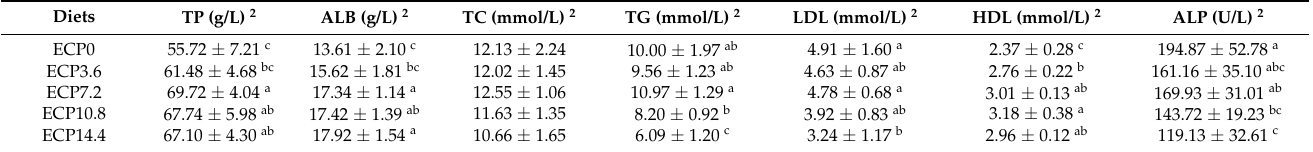
Table 3. Effect of replacing FM with ECP on plasma biochemical parameters of juvenile largemouth bass ( Micropterus salmoides ) 1